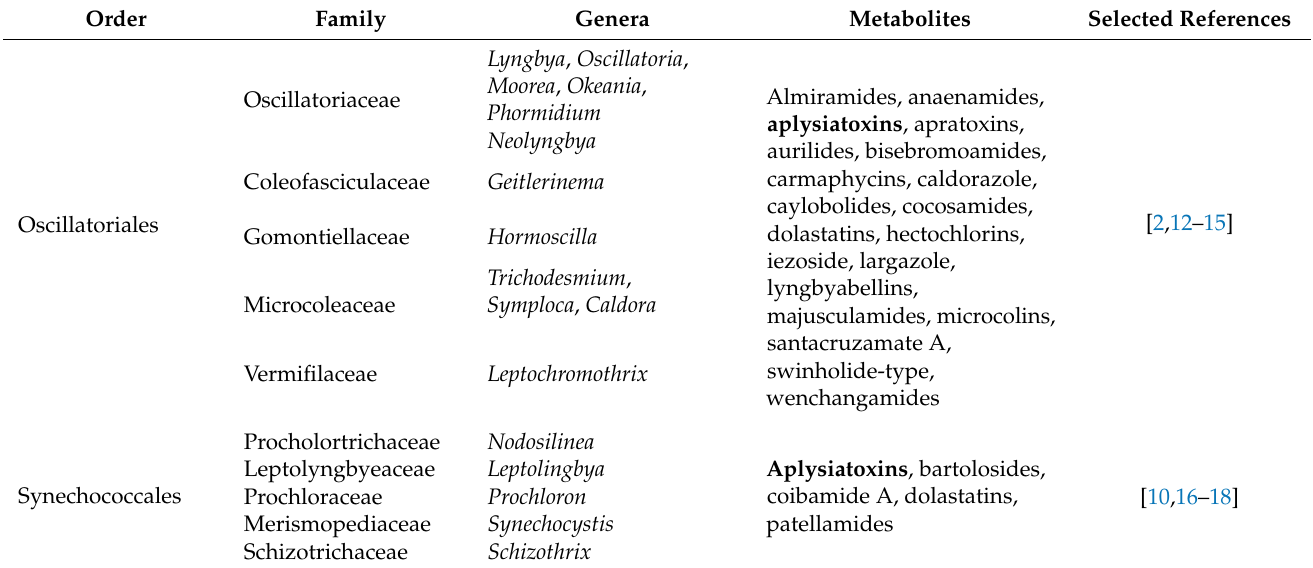
Table 2. Metabolites produced by members of orders Oscillatoriales and